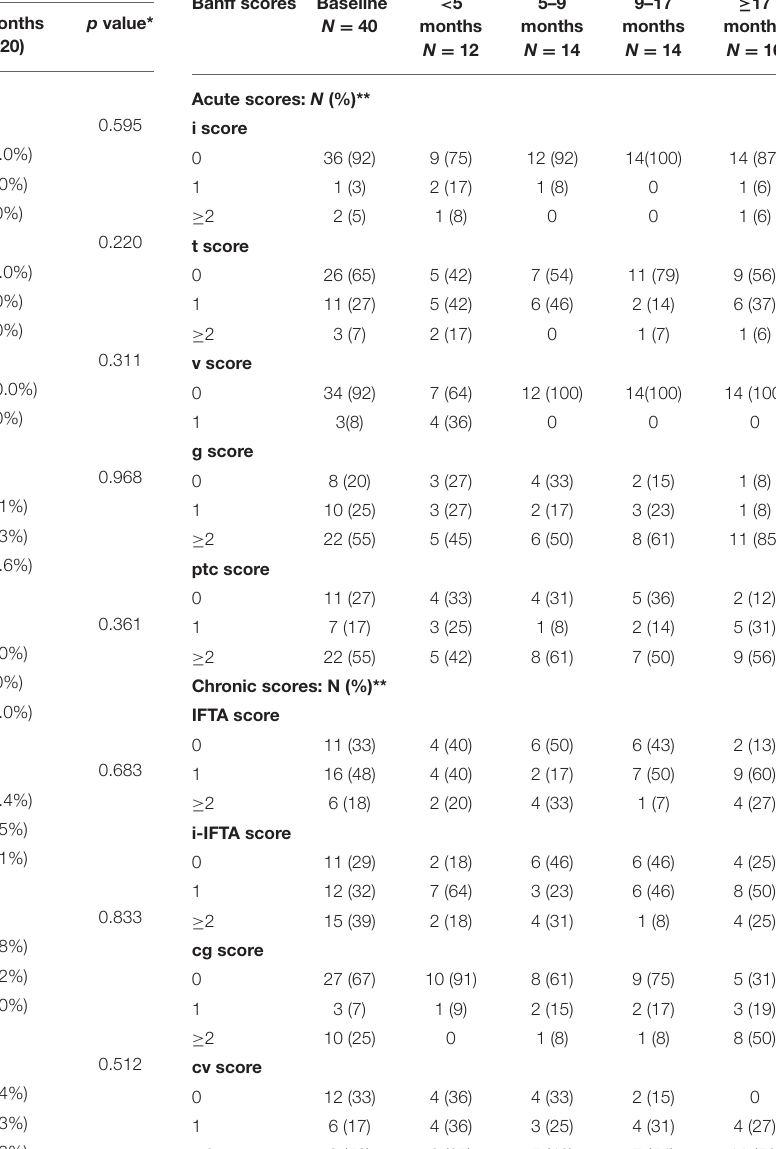
TABLE 2 | Histological Banff scores during the first year post-TCZ treatment for cAMR.